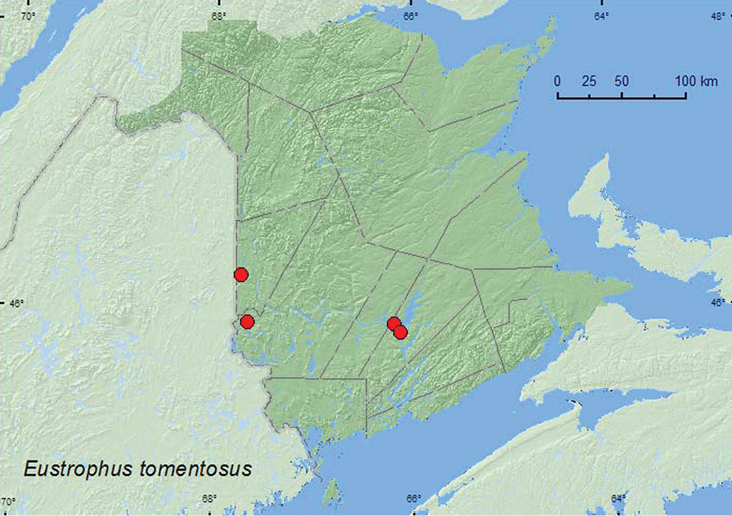
Collection localities in New Brunswick, Canada of Eustrophus tomentosus.